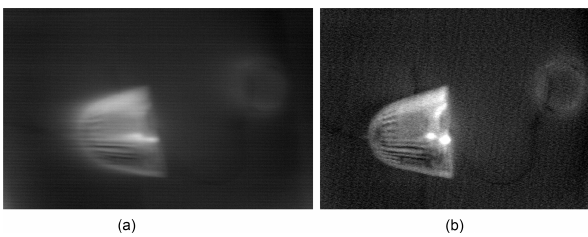
Figure 14. Infrared image of a small warm ball (a) , gradient image with marked motion direction (b) , edges of the gradient image (c) ; restored image (d) .